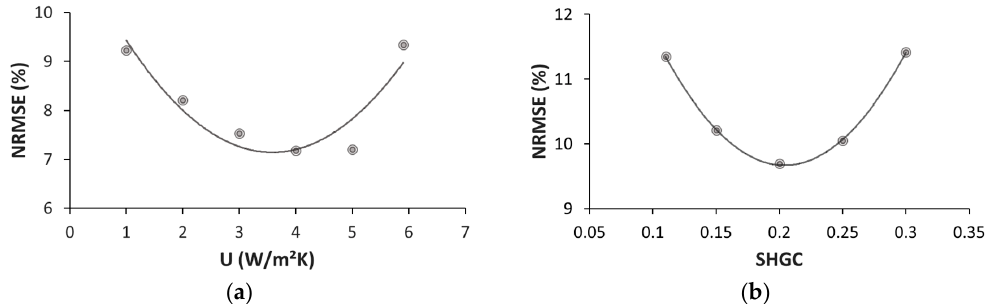
Figure 9. ( a ) NMRSE versus U-value for the evaluation of U-value of DSM. ( b ) NMRSE versus SHGC for the evaluation of SHGC of DSM.